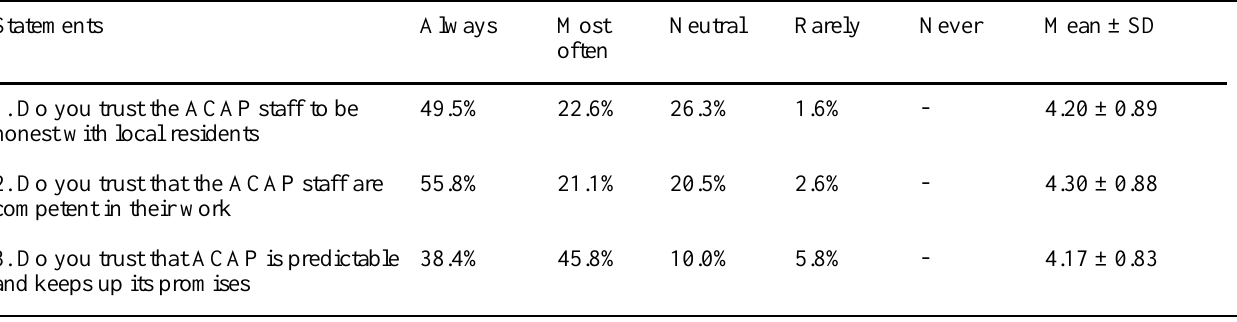
Table 2 . Summary results of the three indicators used to measure the levels of trust building between Conservation Area Management Committees and the Annapurna Conservation Area Project. Conservation Area Management Committee members rated the following statements on a 5-point scale: always = 5, most often = 4, neutral = 3, rarely = 2, never = 1. (Source: authors’ interview data; n =